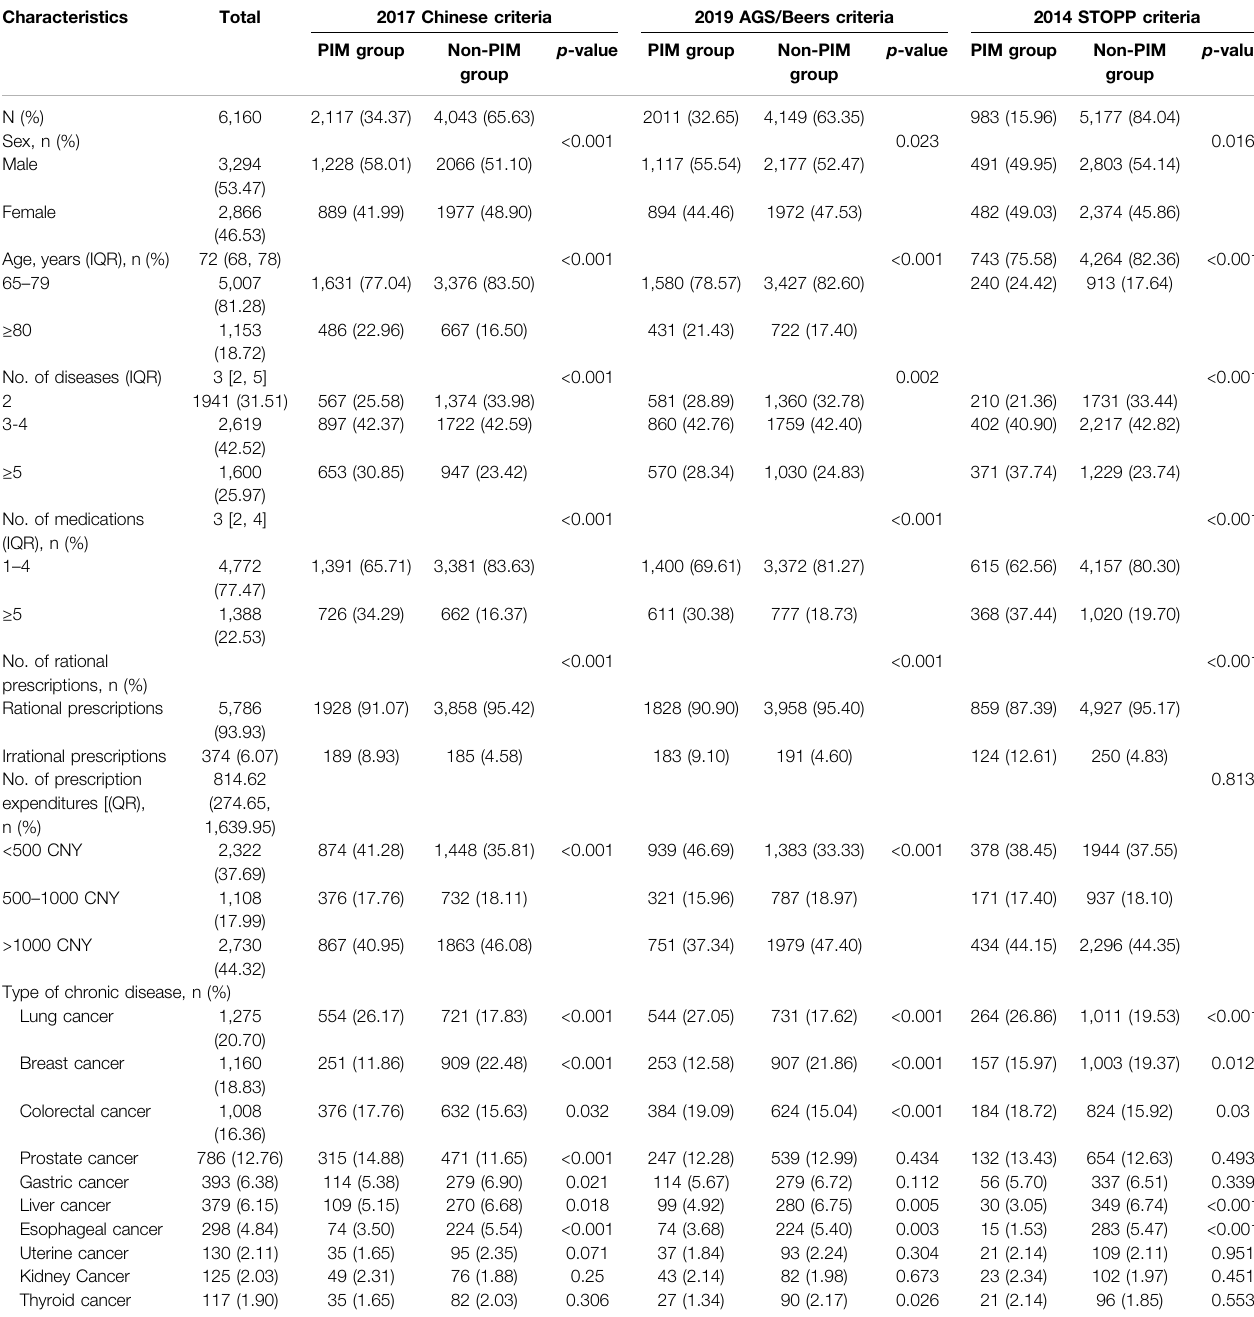
TABLE 1 | Basic characteristics of older cancer